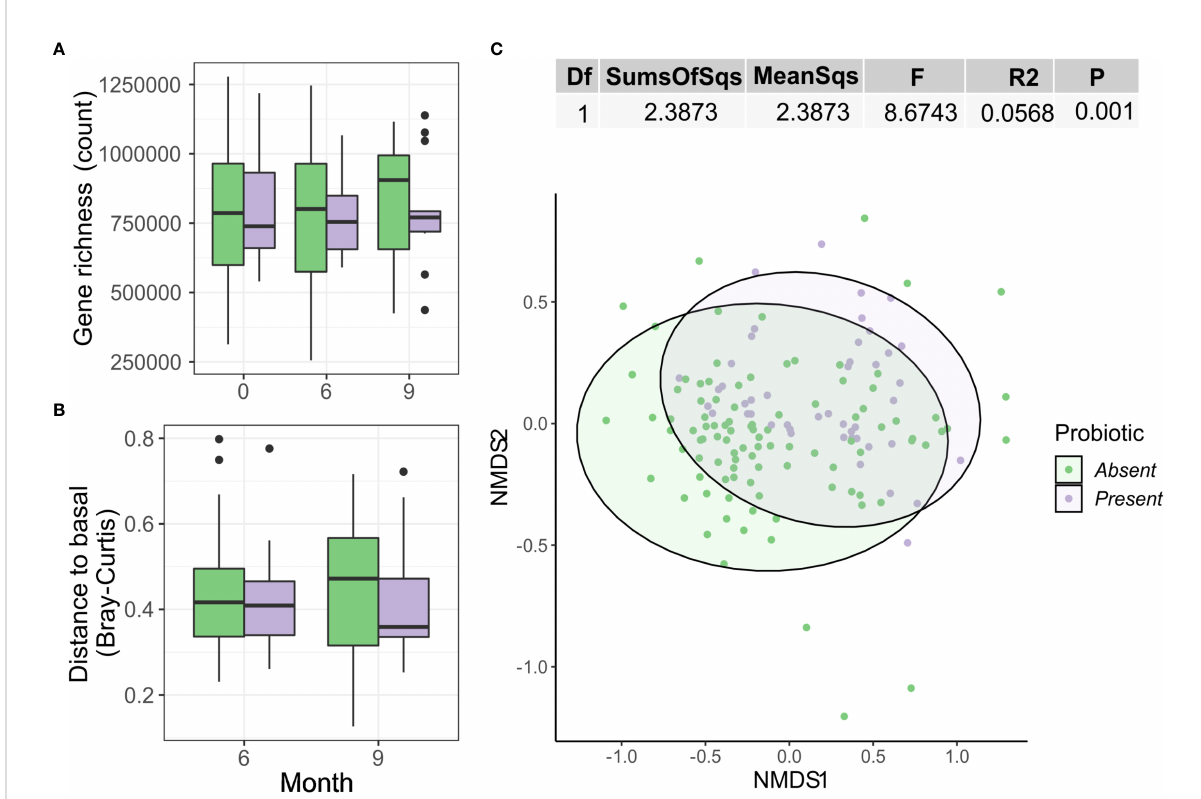
FIGURE 6 Differences by presence or absence of the probiotic strains on the gut microbiome. (A) Gene richness counts for each group arm and month. Comparisons between group at each timepoint were used simple Wilcoxon test, while the paired version was used for within-group comparisons between months. (B) Distribution of Bray Curtis-Distances from baseline for each month and group. (C) NMDS showing sample ordination according to Bray-Curtis distance. Group distance dissimilarity was tested using